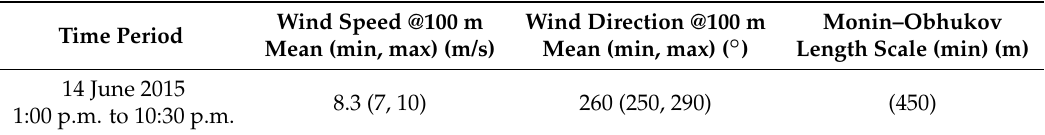
Table 2. Wind conditions observed during the selected time period. Times are local (UTC +